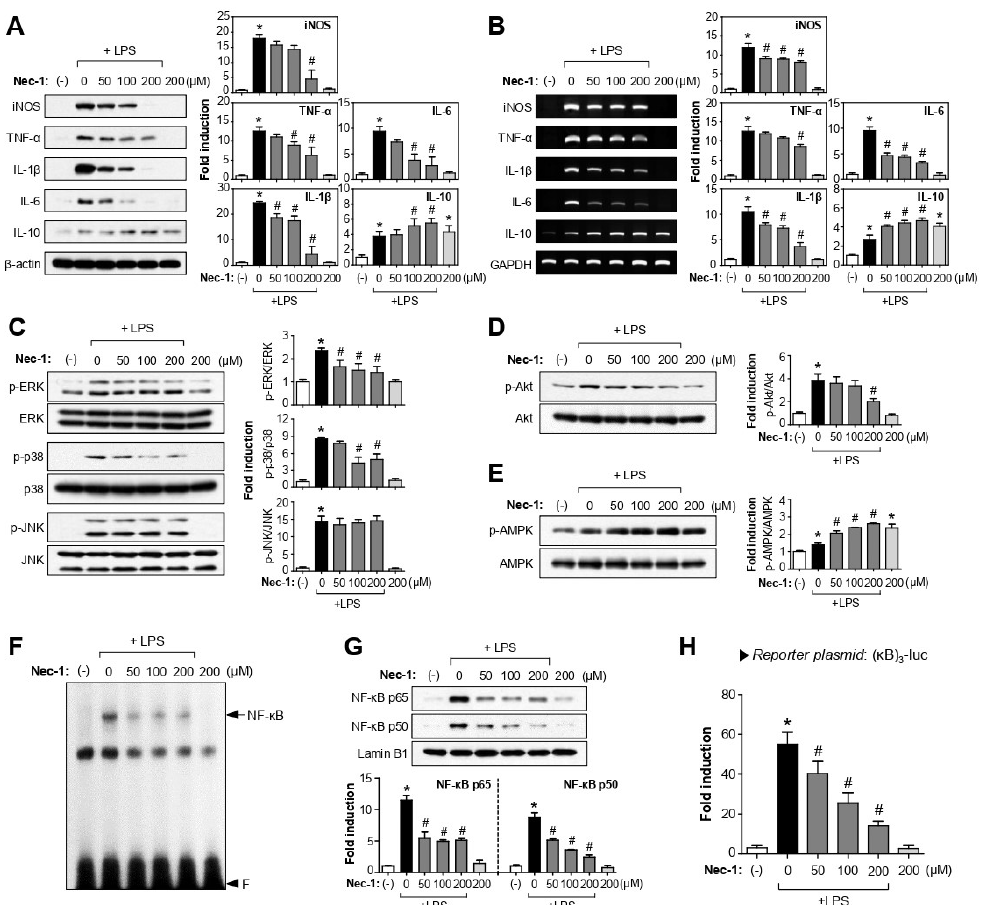
Figure 3. Effect of Nec-1 on inflammatory cytokines and signaling molecules such as MAPKs, Akt, AMPK, and NF- κ B in LPS-stimulated BV2 cells. ( A , B ) BV2 cells were pretreated with Nec-1 for 1 h and incubated with LPS (100 ng/mL) for 6 h. Western blot analysis ( A ) and RT-PCR ( B ) were performed to measure the expression of TNF- α , IL-1 β , IL-6, and IL-10. ( C – E ) BV2 cells were pretreated with Nec-1 and incubated with LPS (100 ng/mL) for 1 h. Western blot analysis using antibodies against the phospho-forms of ERK, p38, JNK, Akt, and AMPK were normalized with respect to the level of each total form and expressed as fold changes relative to the control group. ( A – E ), representative gels are shown in the left panel, and the quantification of three independent experiments is shown in the right panel. ( F ) EMSA for NF- κ B was performed using nuclear extracts prepared from BV2 cells pretreated with Nec-1 and incubated with LPS (100 ng/mL) for 1 h. ( G ) Effect of Nec-1 on nuclear translocation of NF- κ B subunits. ( H ) Transient transfection analysis of ( κ B) 3 -luc reporter gene activity. Data are shown as the mean ± SEM of three independent experiments. * p < 0.05 vs. control; # p < 0.05 vs. LPS-treated